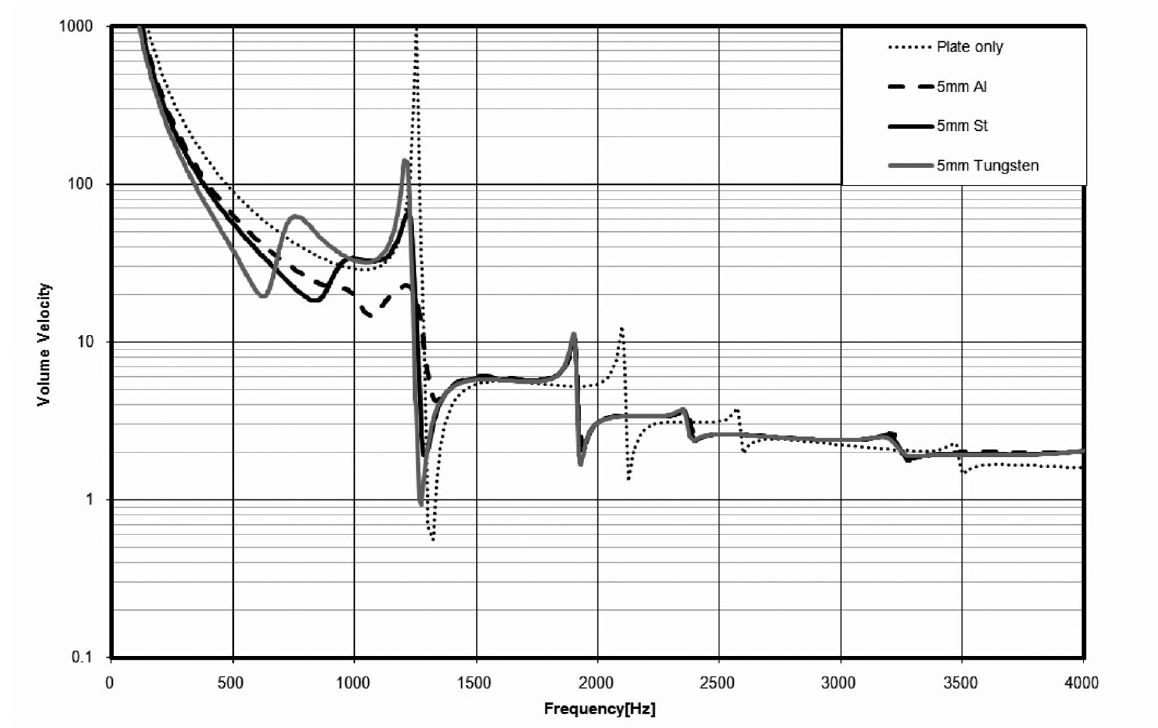
Fig. 58. Frequency response curves for four cases of free-free plate Plate only (dotted), Plate with added Steel ball EIDL (solid black), Plate with added Aluminium ball EIDL (dashed), Plate with added Tungsten ball EIDL (solid grey).